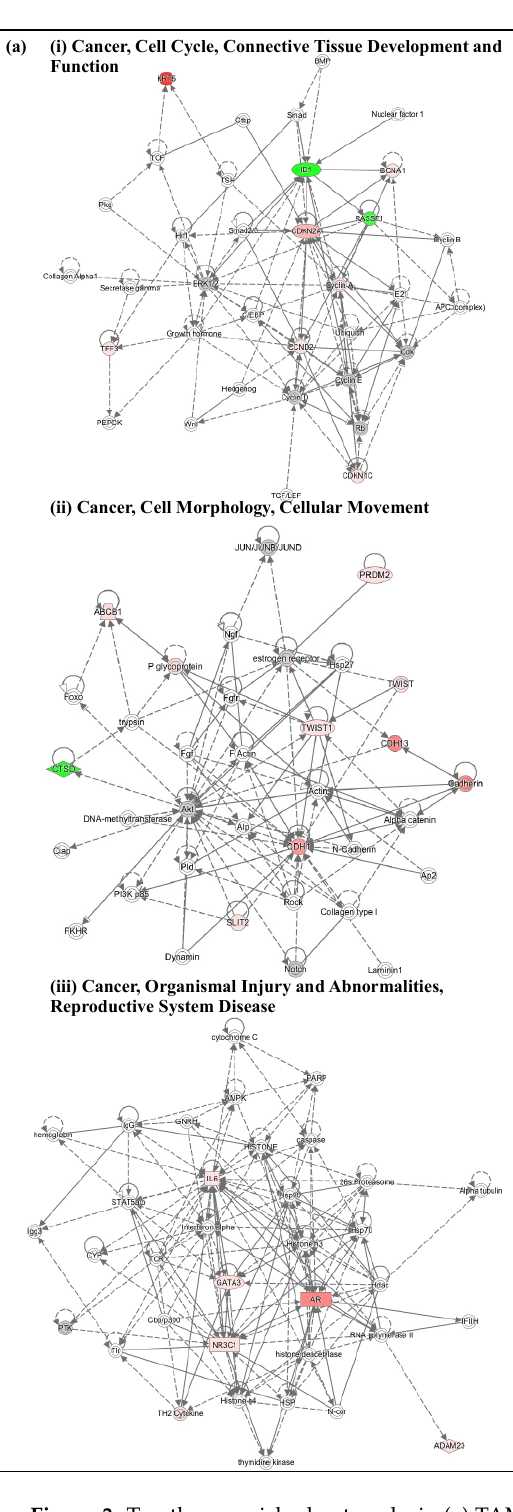
Figure 3. Top three enriched networks in ( a ) TAM-treated; ( b ) M1S9-treated MDA-MB-231 xenograft tumor. Up / downregulated genes (fold changes ≥ ± 2) are colored in red and green, respectively, while the color intensities are relative to fold change. Nodes without color were neither expressed nor assessed in this study. Abbreviation: TAM—tamoxifen.